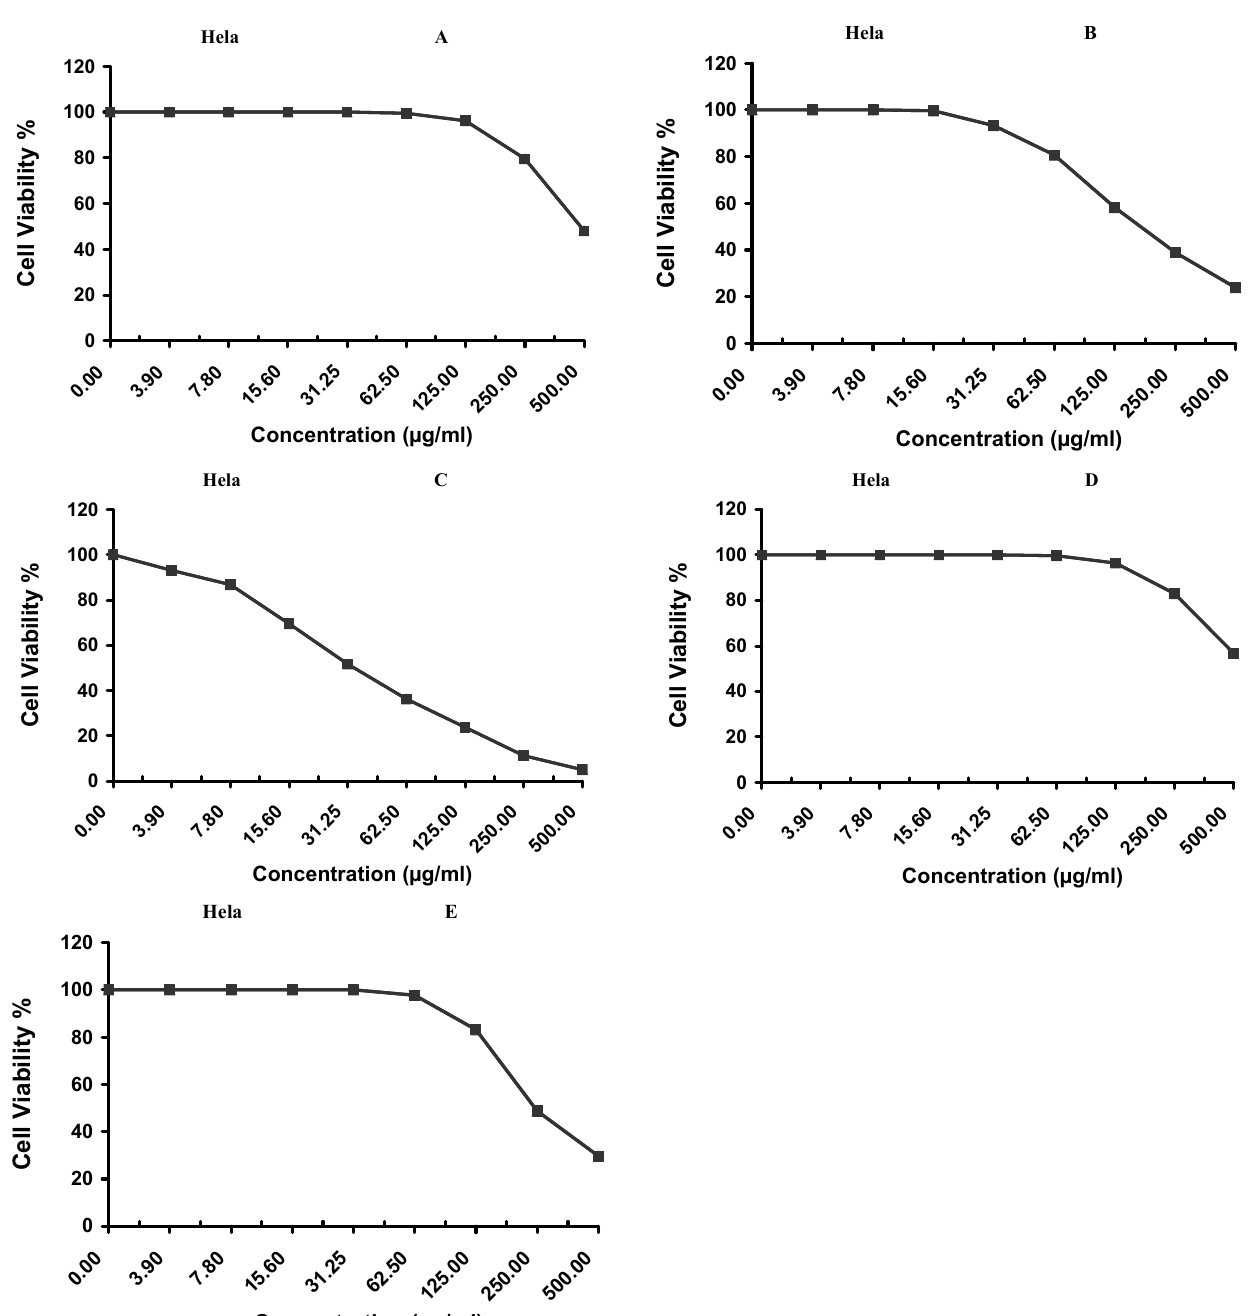
Figure A4. The percentage of cell viability of cervical cancer cell lines (HeLa) upon treatment with different doses of the test samples. ( A ) the unloaded PLGA NPs, ( B ) the PLGA-Cf-F 1 NPs, ( C ) the PLGA-Cf-F 2 NPs and ( D ) the PLGA-Cf-F 3 NPs. Finally, graph ( E ) is for the free coffee extract.